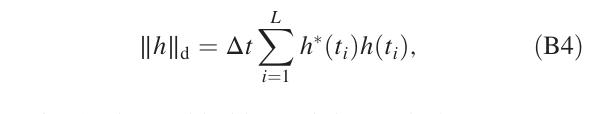
Algorithm 2 : The empirical interpolation